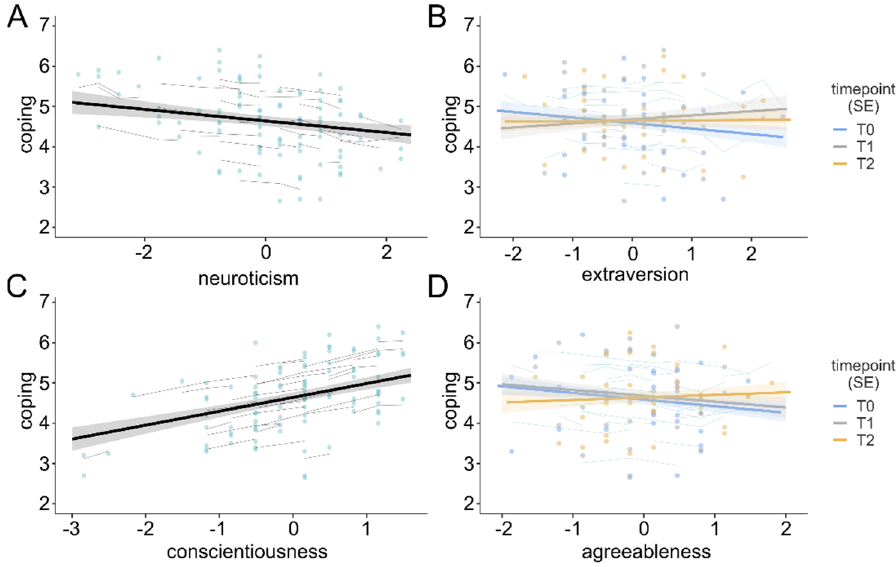
Figure 1. Relation of Big Five traits (mean-centered; Panel ( A ) = neuroticism, Panel ( B ) = extraversion, Panel ( C ) = conscientiousness, Panel ( D ) = agreeableness) and coping, including the different time points (blue = T0, grey = T1, yellow = T2). Shaded error bars mark standard errors; small lines show random effects.